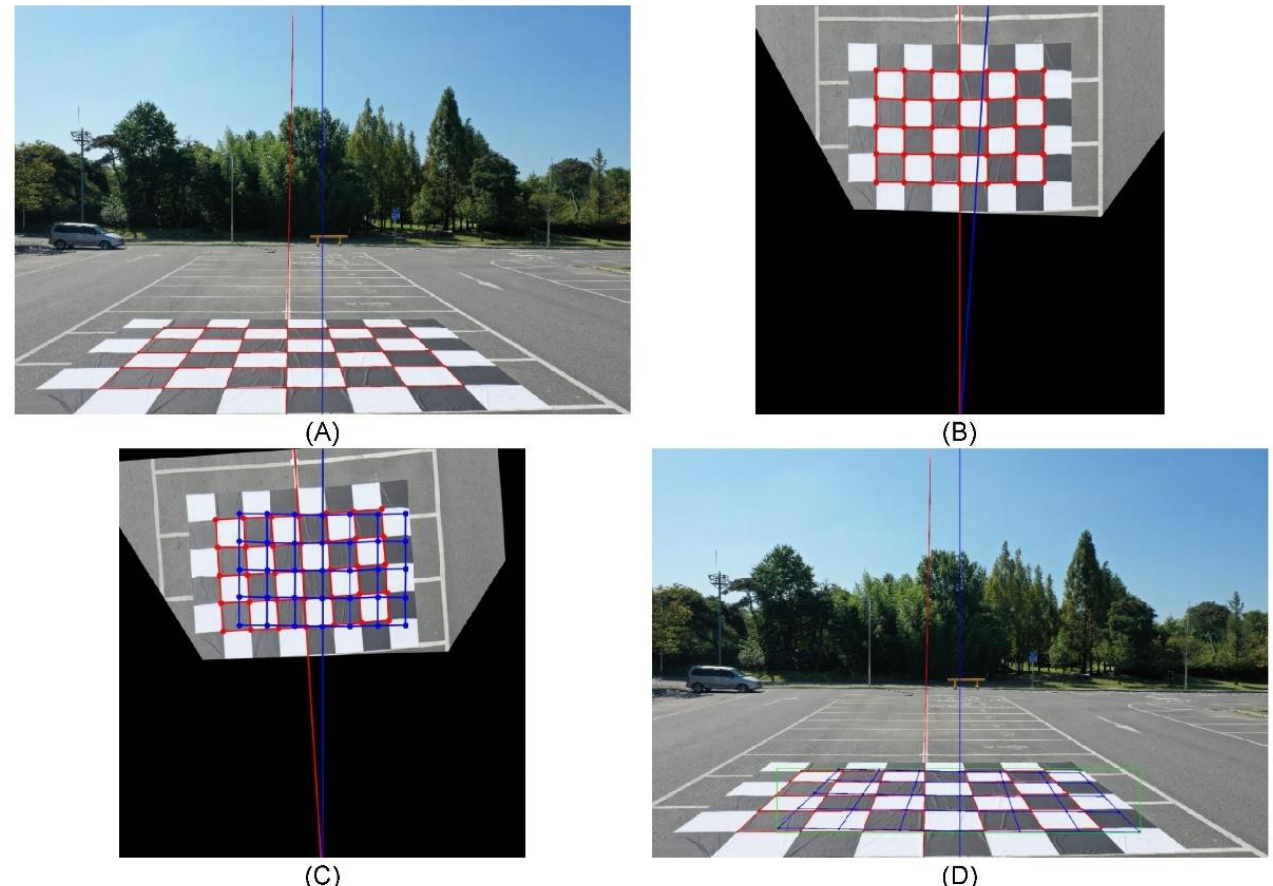
Figure 18. The perspective transformation for camera calibration: ( A ) reference lines and points for performing perspective transformations, ( B ) image projection from pixel coordinate to world coordinate, ( C ) center compensation based on the camera center point, ( D ) calculated recognition range using camera calibration.